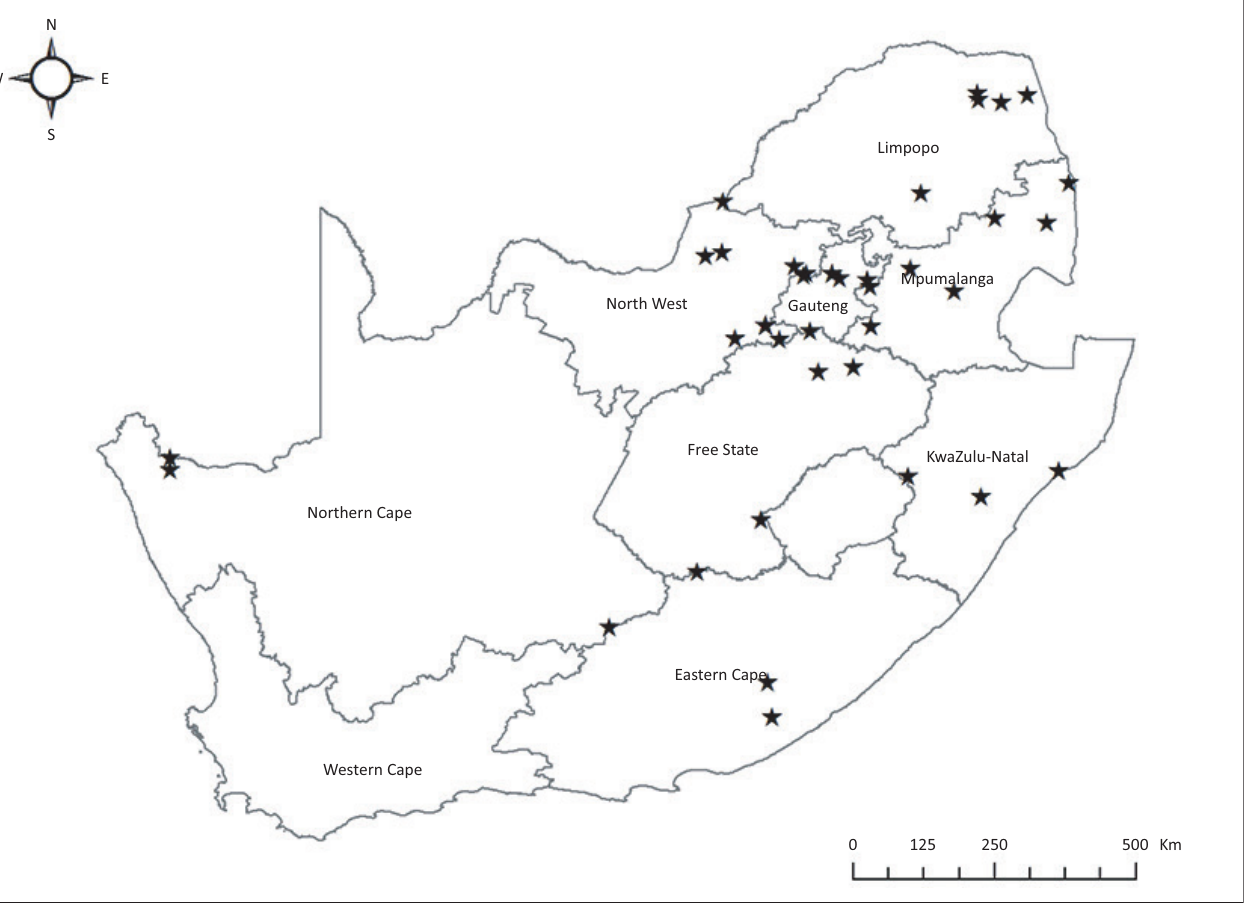
FIGURE 2: Distribution of Unio caffer in South Africa, redrawn using occurrence records from De Kock and Wolmarans (2010). The black stars represent U. caffer